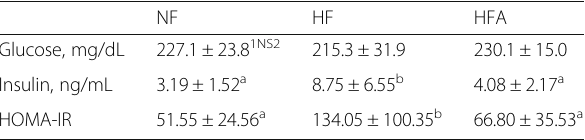
Table 3 The effect of A. pilosa on serum glucose, insulin, and HOMA-IR